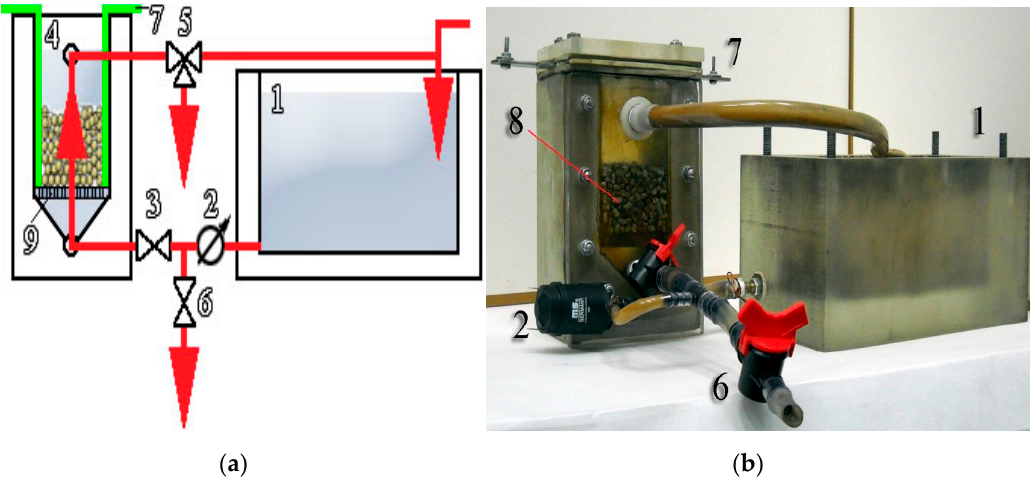
Figure 5. ( а ) The hydraulic scheme and ( b ) the appearance of the reactor.